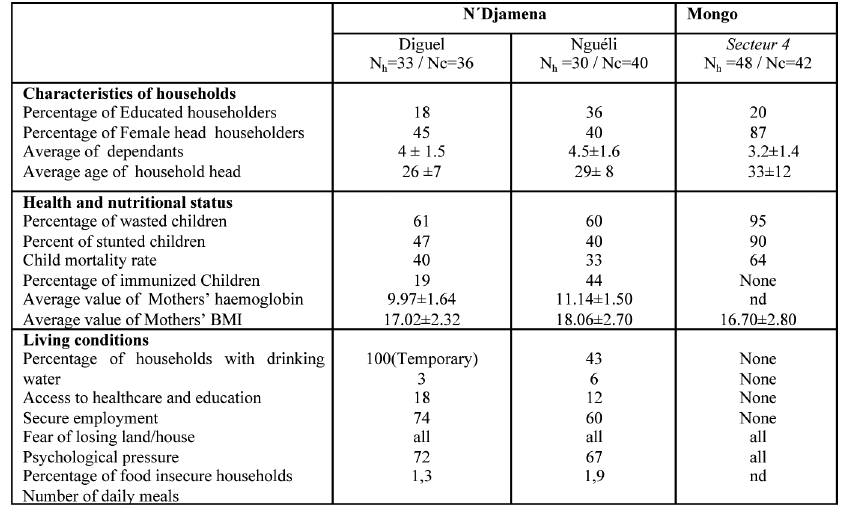
§Nh = Number of Households, Nc = Number of children under